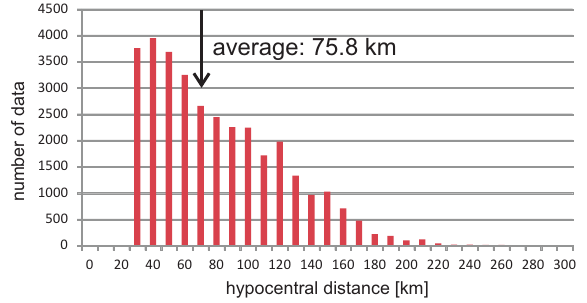
Fig. 3. Distribution of the hypocentral distances r for the data, used in the inversion. The average distance is indicated by the arrow.